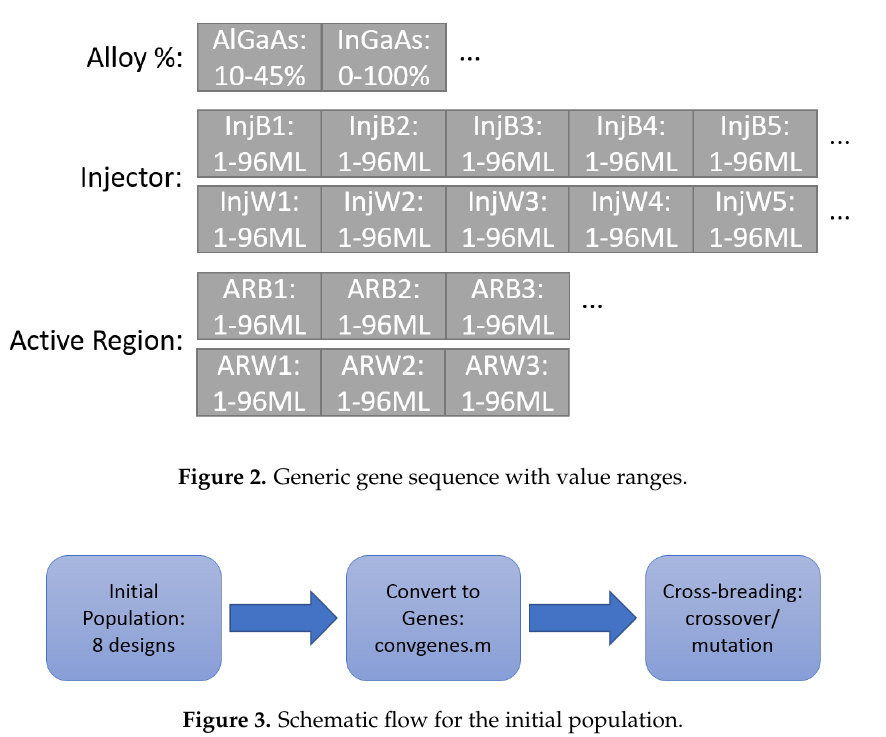
Figure 3. Schematic flow for the initial